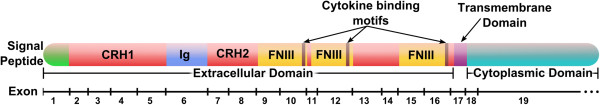
The LIFR protein with domains and exons shown. The numbers indicate the location of the 19 exons (figure not to scale). The domains (CRH1, Ig, CRH2, FNIII, TD and CD) are illustrated within their corresponding region of the protein (extracellular, transmembrane, or cytoplasmic). SP: signal peptide; CRH: cytokine receptor homology domain; Ig: Ig-like domain; FNIII: type III fibronectin domain; TM: transmembrane domain; CD: cytoplasmic domain.